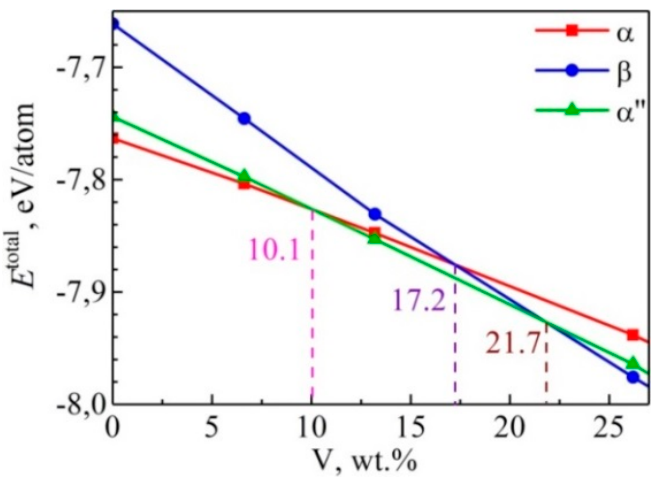
Figure 11. Total energy per atom in α -, β -, and α ‘‘-Ti as a function of vanadium content. The mechanism underlying the α (cid:48) → α (cid:48)(cid:48) transformation is well known. As the solute element content increases, the distortion of the hexagonal α ‘ martensite occurs. As a result, the α ‘ martensite loses its hexagonal symmetry and the orthorhombic α “ phase is formed [42,43]. In our experiments, the higher lattice distortion of the EBAM Ti-6Al- 4V samples is attributed to the higher cooling rate. The high microstrains are direct evidence of the high local lattice distortion in the EBAM Ti-6Al-4V samples produced with substrate